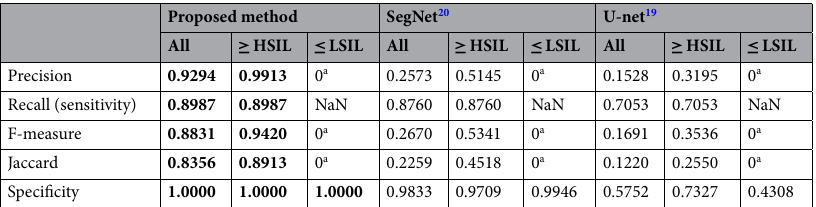
Table 3. Quantitative evaluation of the proposed method and two benchmark methods (U-Net and SegNet) in segmenting of HSILs or higher (SQCC). The proposed method is significantly better than the